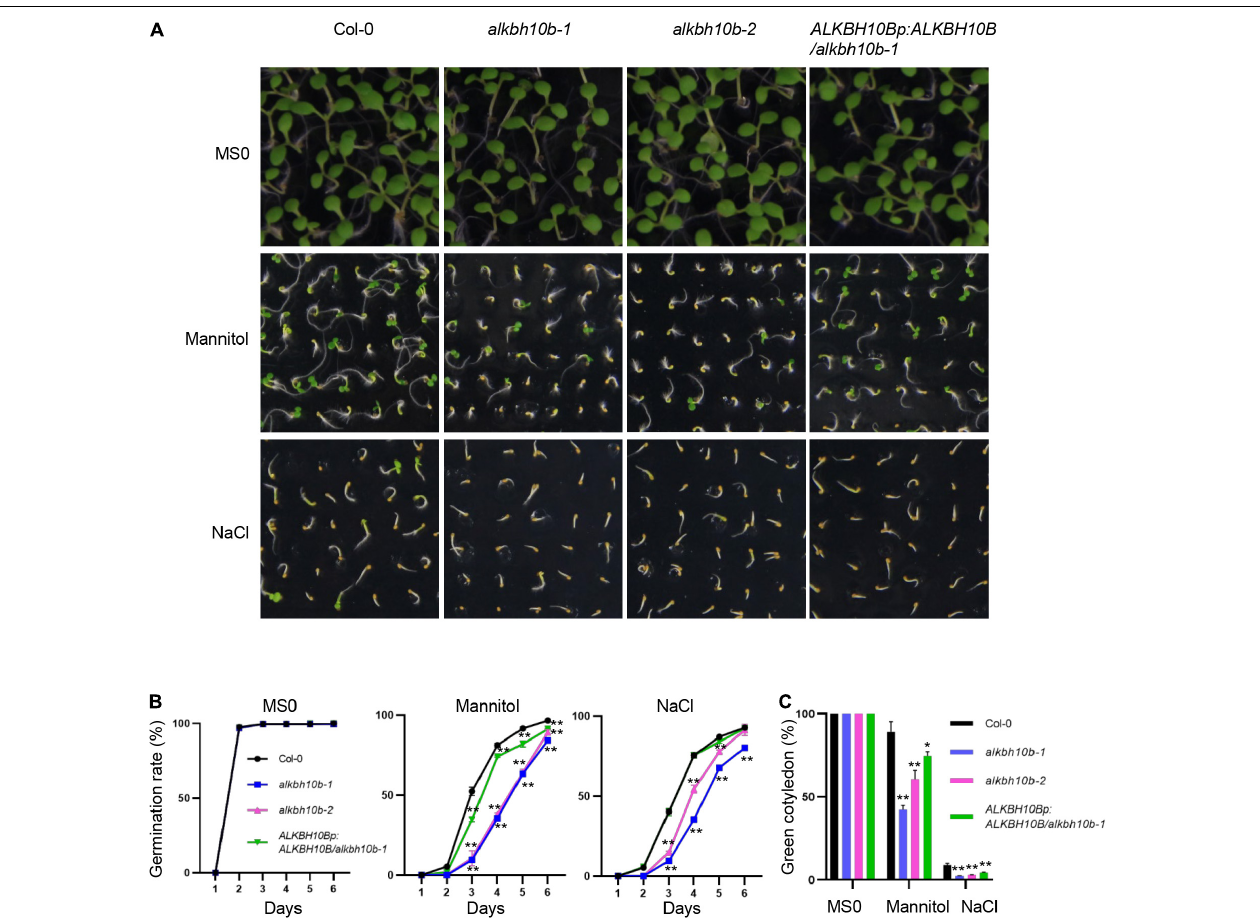
FIGURE 3 | ALKBH10B modulates osmotic and salt stress response during seed germination. The germination rates of indicated genotypes were recorded from 1–6 days after stratification in the presence of 300 mM mannitol or 150 mM NaCl. Cotyledon-greening percentages of the 8th day were recorded. Three independent experiments were conducted, with at least 100 seeds per genotype in each replicate. Error bars represent the standard deviation of three replicates. Asterisks indicate statistically significant differences as compared to the mock of every time-point (* P < 0.05; ** P < 0.01; Student’s t -test). (A) Photographs of seedings grown on different media at day 6 after stratification. (B) Seed germination rates of indicated genotypes grown on different medium. (C) Green cotyledon ratio at day 8 after stratification.